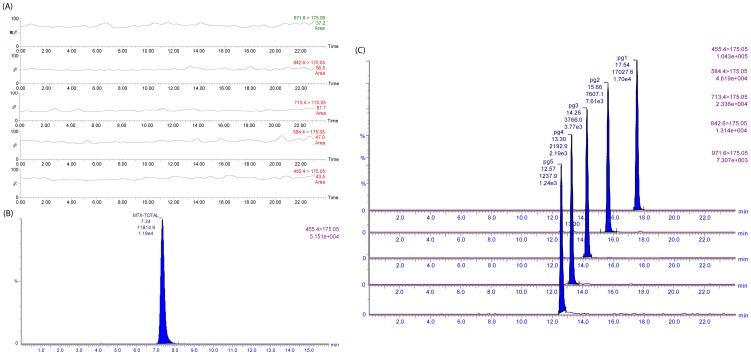
Representative MRM chromatograms of a blank DBS sample (A), DBS spiked with MTXPGs (final total concentration of 100 nM) subjected to enzymatic conversion to MTXPG1 (B), and DBS sample spiked with MTXPG1–5 measured individually at a final concentration of 100 nM each (C).